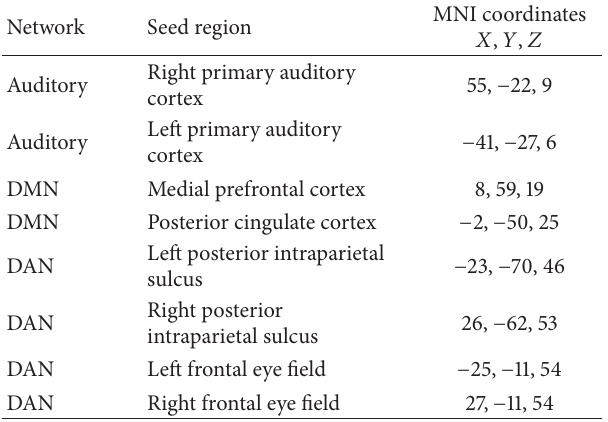
Table 2: List of seed regions used during the resting state connec- tivity analysis. DMN: default mode network; DAN: dorsal attention